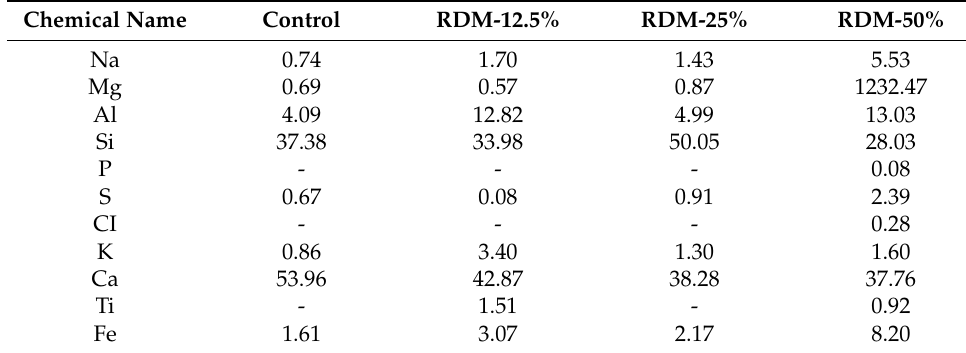
Table 5. Energy dispersive spectroscopy (EDS) Results